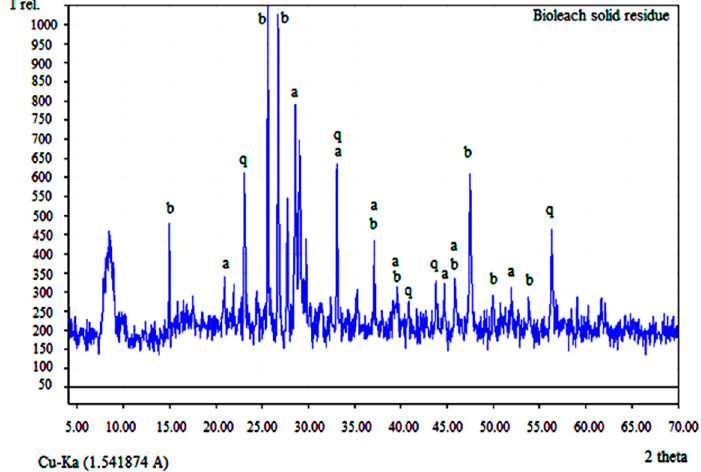
Figure 6. X-ray diffraction pattern of the bioleach residue where a—anglesite; b—beudantite; and Figure 6. X-ray di ff raction pattern of the bioleach residue where a—anglesite; b—beudantite; q—quartz. and